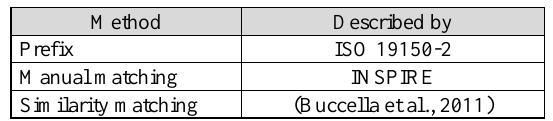
Table 5. Methods for attribute globalization